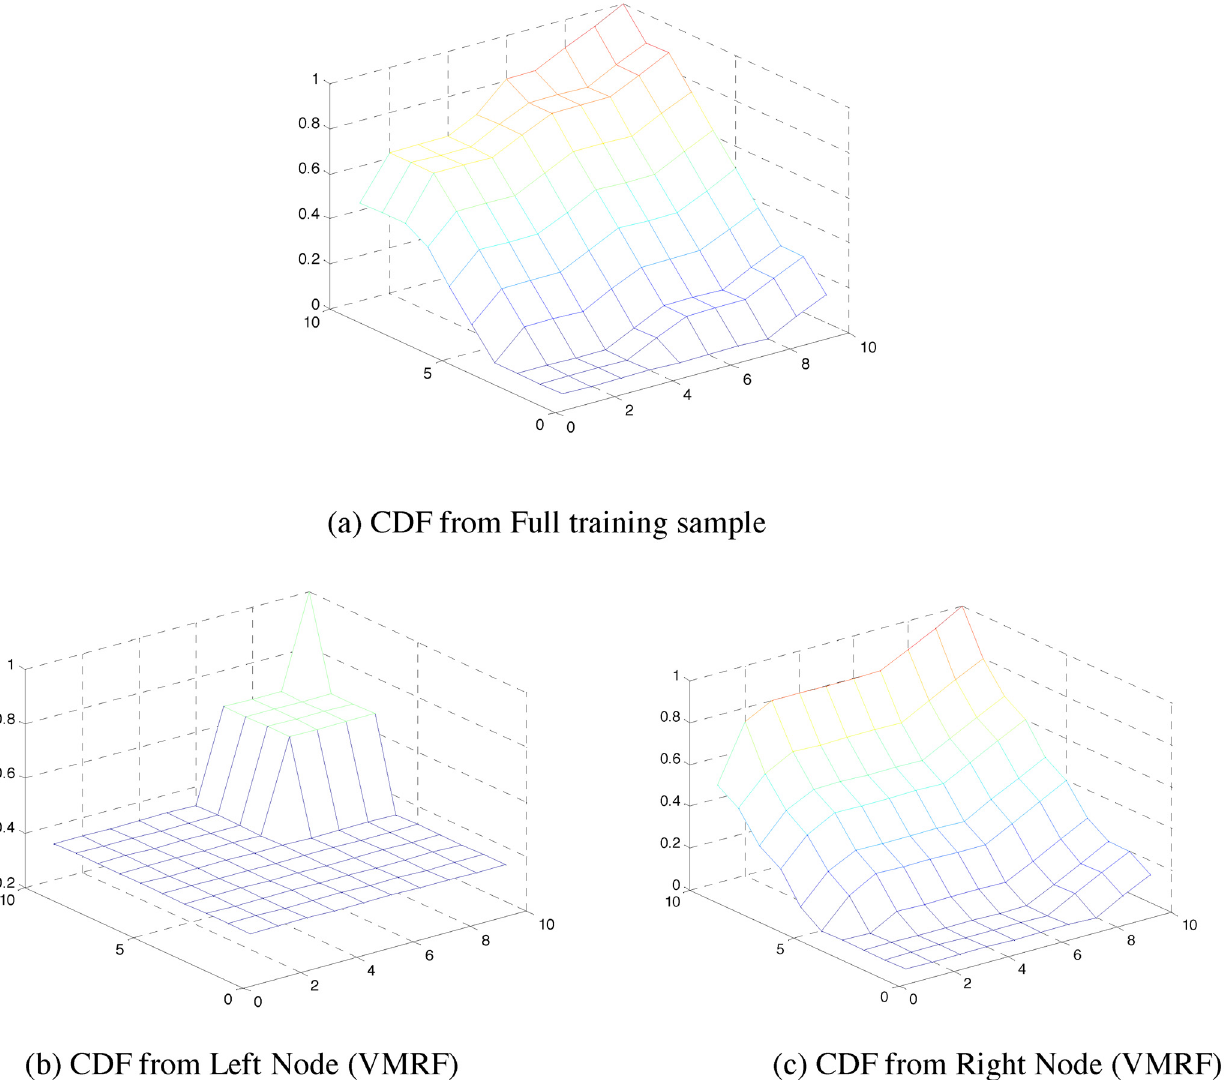
Fig 6. CDF created from left and right child node for a single split using VMRF. It is compared visually with the original CDF created from the training samples.